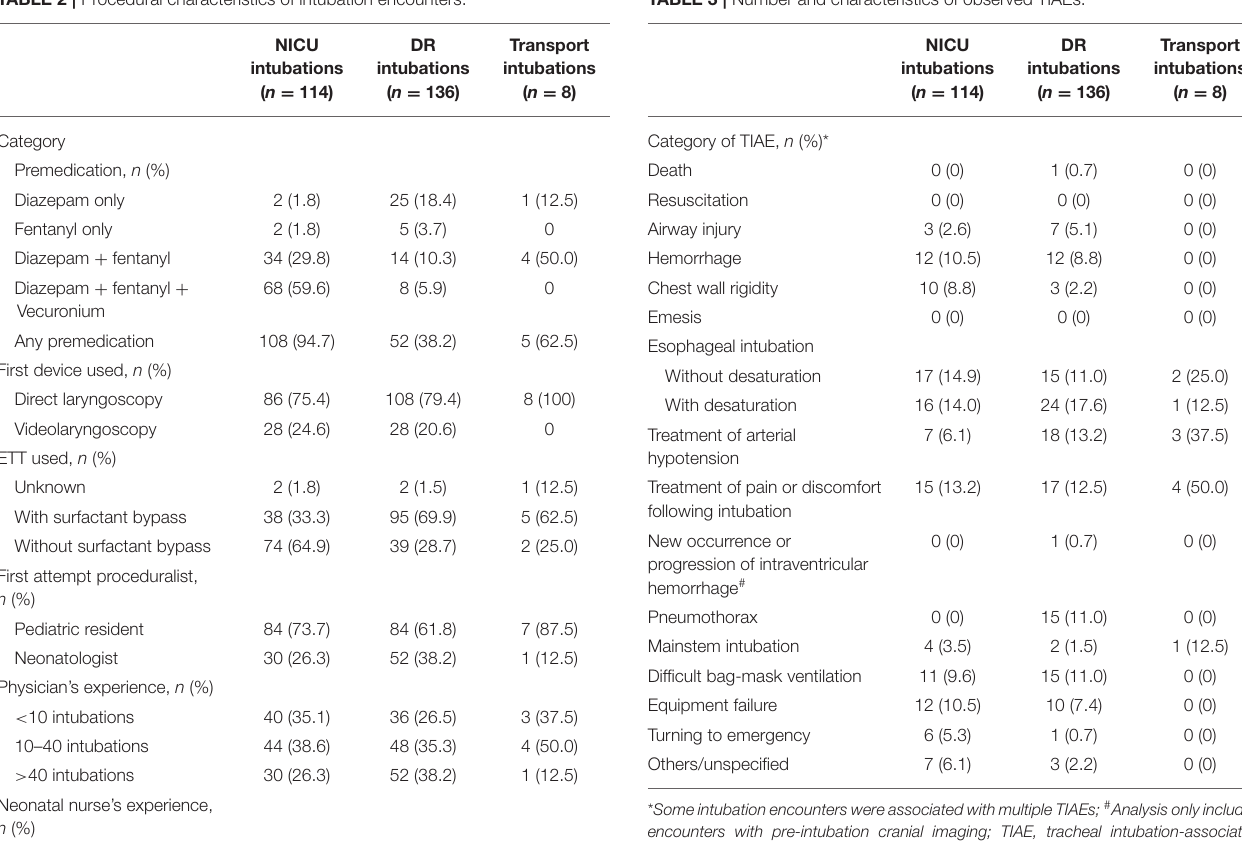
TABLE 2 | Procedural characteristics of intubation encounters. TABLE 3 | Number and characteristics of observed